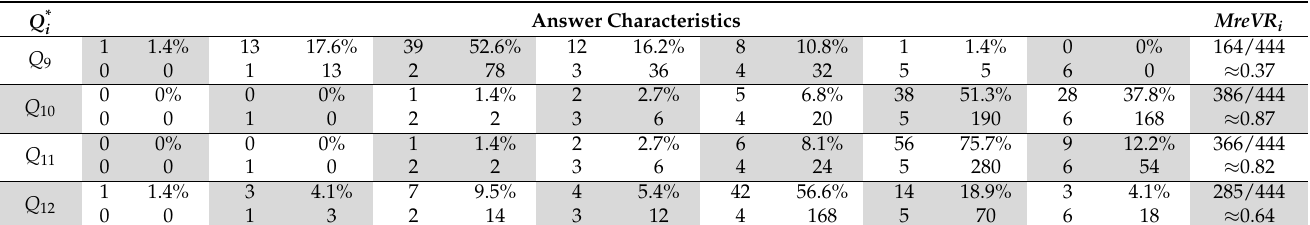
Table 3. Barriers to sustainable marketing mix